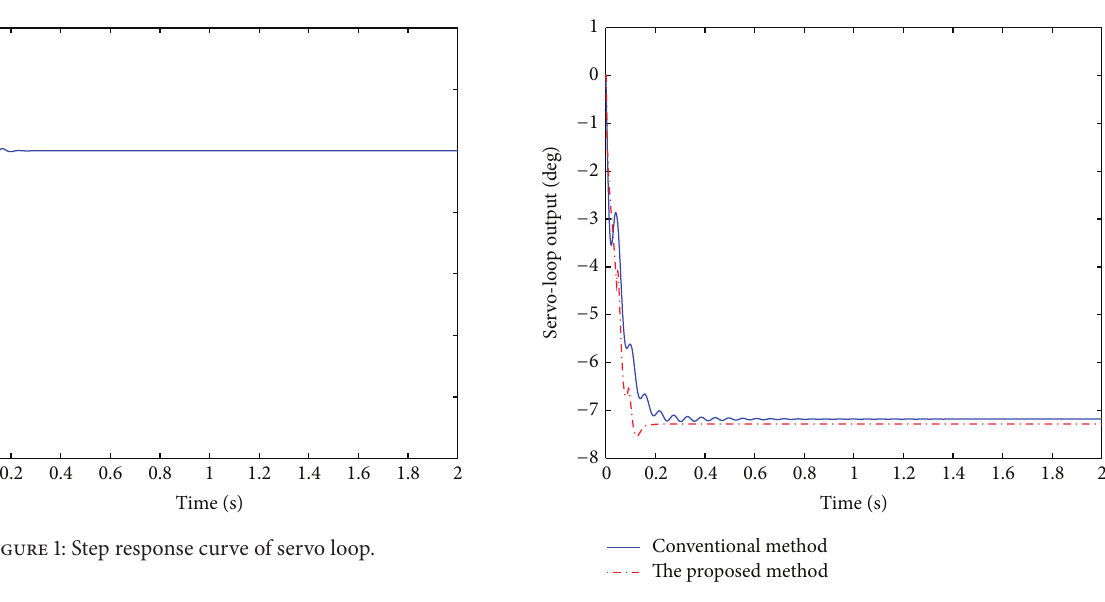
Figure 3: Output curves of servo loops under the two control schemes.